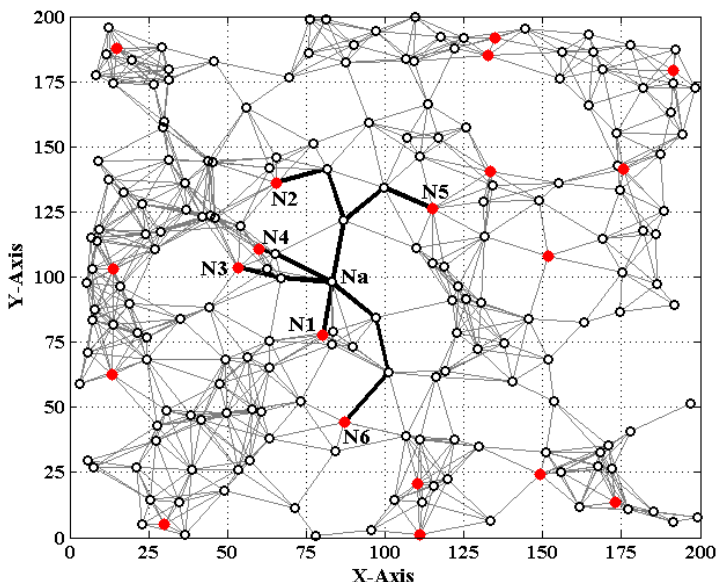
Figure 1. Isotropic network.